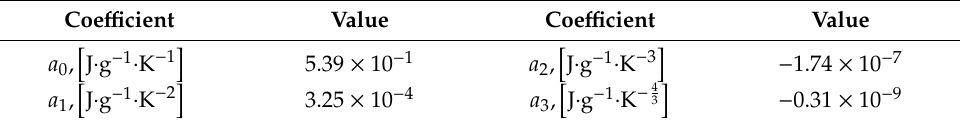
Table 2. Coefficients for calculating specific heat capacity of 38HMJ steel based on Equation (3).